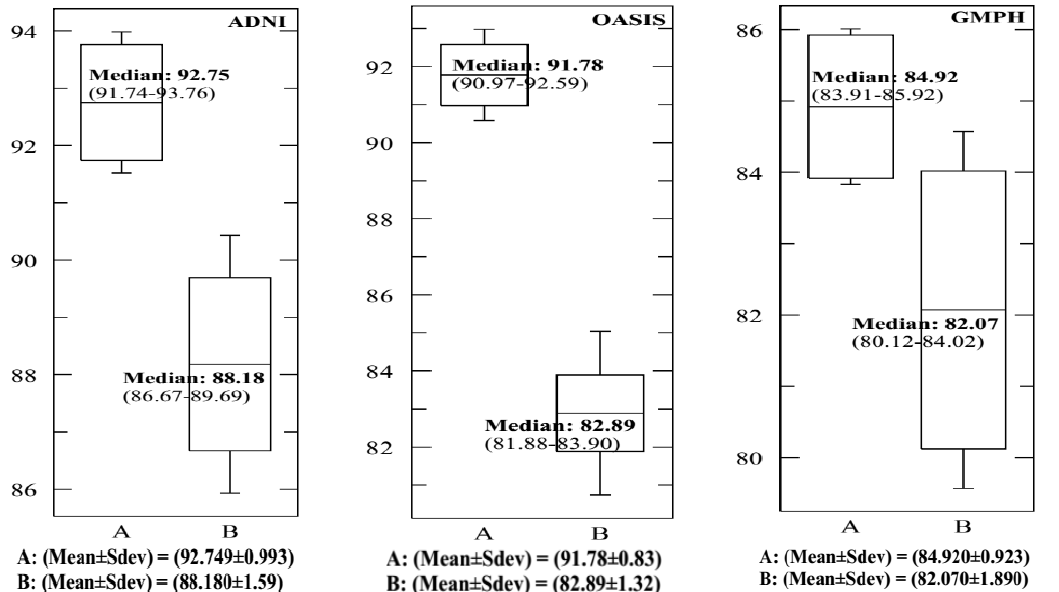
Figure 17. The corresponding Box-and-whisker plots of the descriptive statistics of the specificity (SP) values for ADNI, OASIS and GMPH datasets with 20% additive noise, using 10-fold cross-validation to evaluate the proposed SVDD classifier based on BCFCM/GA/PFCM segmentation approach (case A in figure). Comparison with SVM classifier, based on BCFCM/GA/PFCM (case B ).